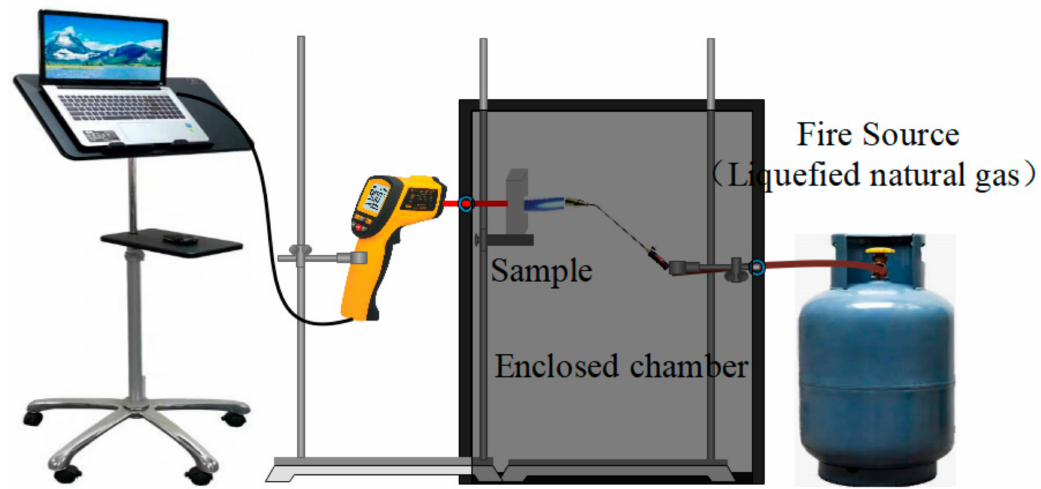
Figure 1. The setup for determining the fire-resistance performance of the